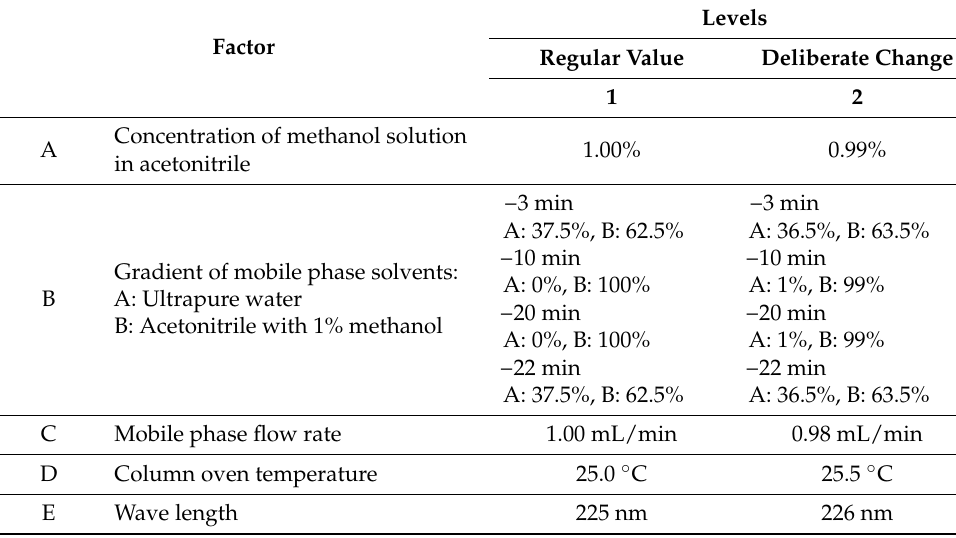
Table 1. Factors and levels studied during the evaluation of the ruggedness of the DEHP determina- tion method in